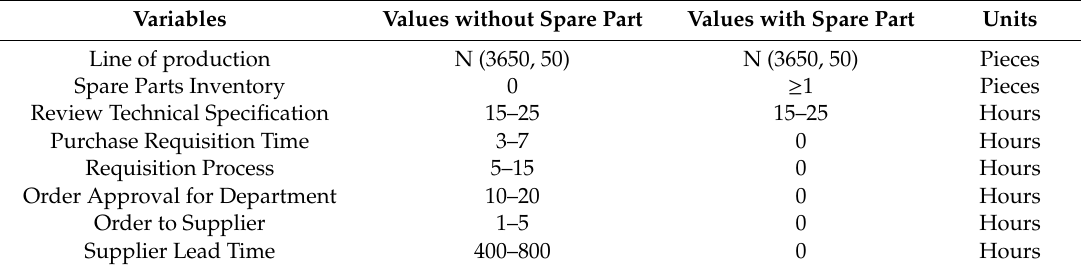
Table 1. Initial simulation